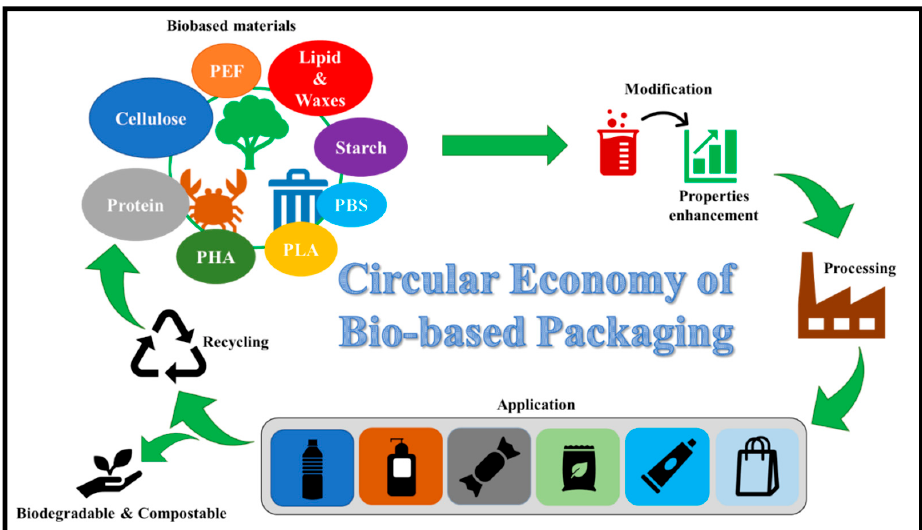
Figure 4. Schematic of bio-derived materials for packaging applications [79]. (PEF: polyethylene furanoate, PLA: polylactic acid, PBS: polybutylene succinate, PHA: polyhydrodyalkanoate).